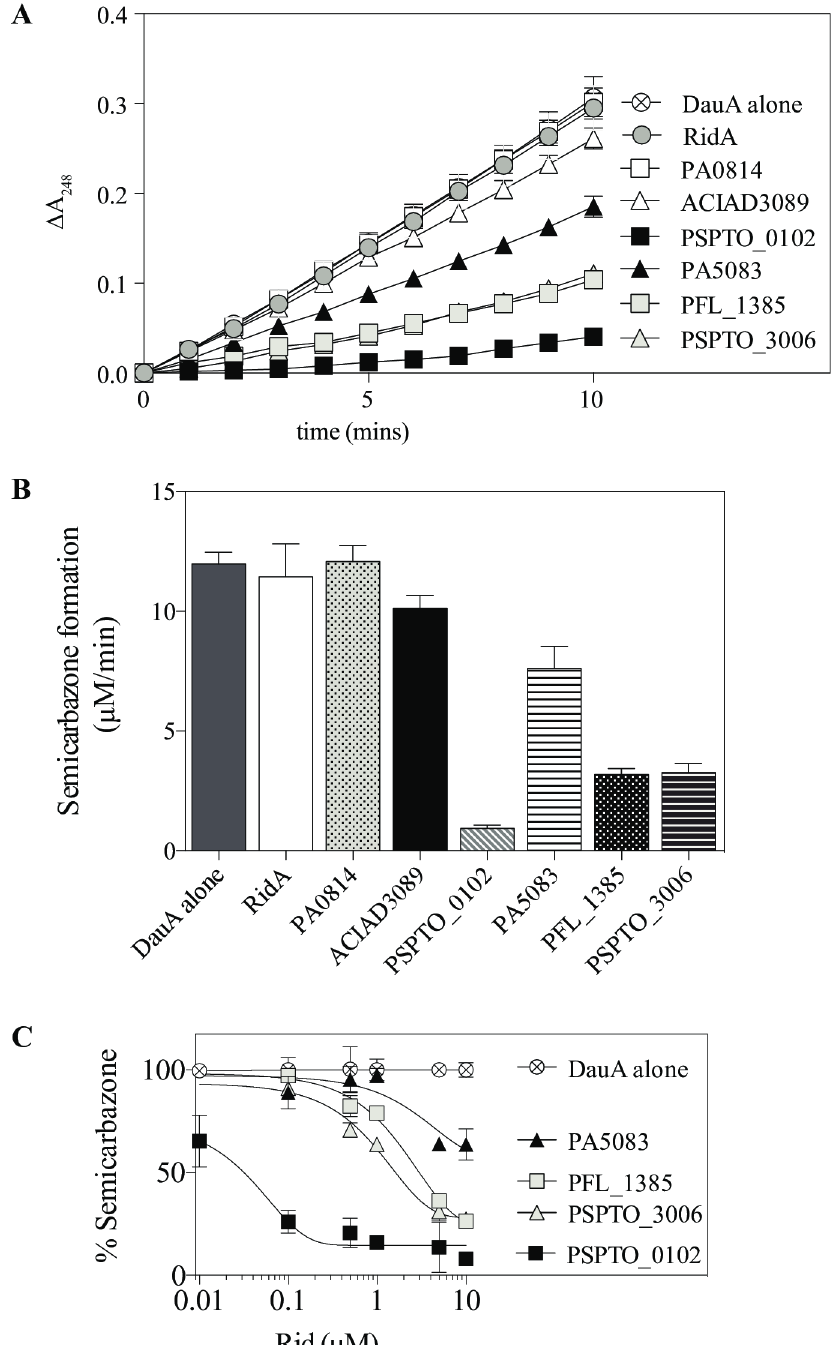
Fig 6. Rid2 and Rid3 proteins deaminate iminoarginine produced by DauA. Assay mixtures (100 μ L) were monitoredin microtiter plate format and containedpotassiumpyrophosphate (50 mM, pH 8.7), neutralized semicarbazide (10 mM), bovine liver catalase(24 Units) and ~1 μ M DauA (1.7 μ M total protein) from the partial purification. (A) Rid protein (10 μ M) was addedand the substrate was D-arginine(1 mM). Followingthe additionof substrate, the path length of each well was measuredand the change in absorbance at 248 nm was monitoredfor ten minutes. (B) The bar graph shows the rate of semicarbazone formation calculatedfrom the observedrate of product formation at 248 nm using the molar extinction coefficient ( ε = 10,300M -1 cm -1 ). (C) The rate of semicarbazone formation is presentedas a percentage of the rate observed in the control (DauA alone)reaction mixture that lacks Rid proteins. All reactionmixtures contained~ 1 μ